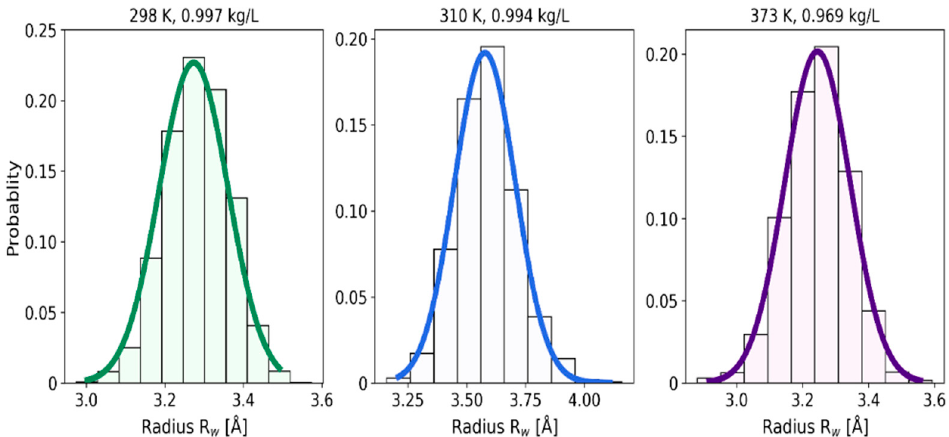
Figure A2. Box-and-whiskers plots displaying median, 1st and 3rd quartiles, minimum (bottom whisker), maximum (upper whisker), and means (points) of statistical distributions of VP-surface obtained for the thermodynamic states, as given in Table 1. Figure A3 shows histograms of the face-weighted radius fitted to normal distributions. Four statistical tests for skewness and kurtosis confirmed that the hypothesis on the nor- mality of the distributions could not be rejected on the significance level of 5%. For the other thermodynamic states from Table 1, fit to normal distribution was not obtained.